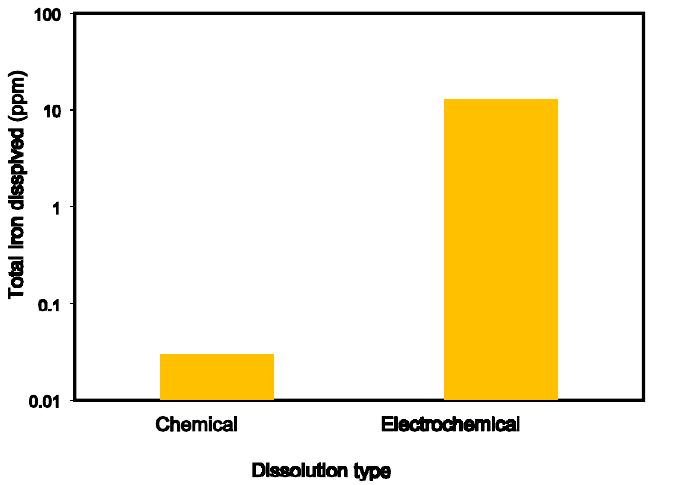
Figure 4. Comparison of total iron dissolved in chemical and electrochemical dissolution in DTPA/K 2 CO 3 solution at room temperature.